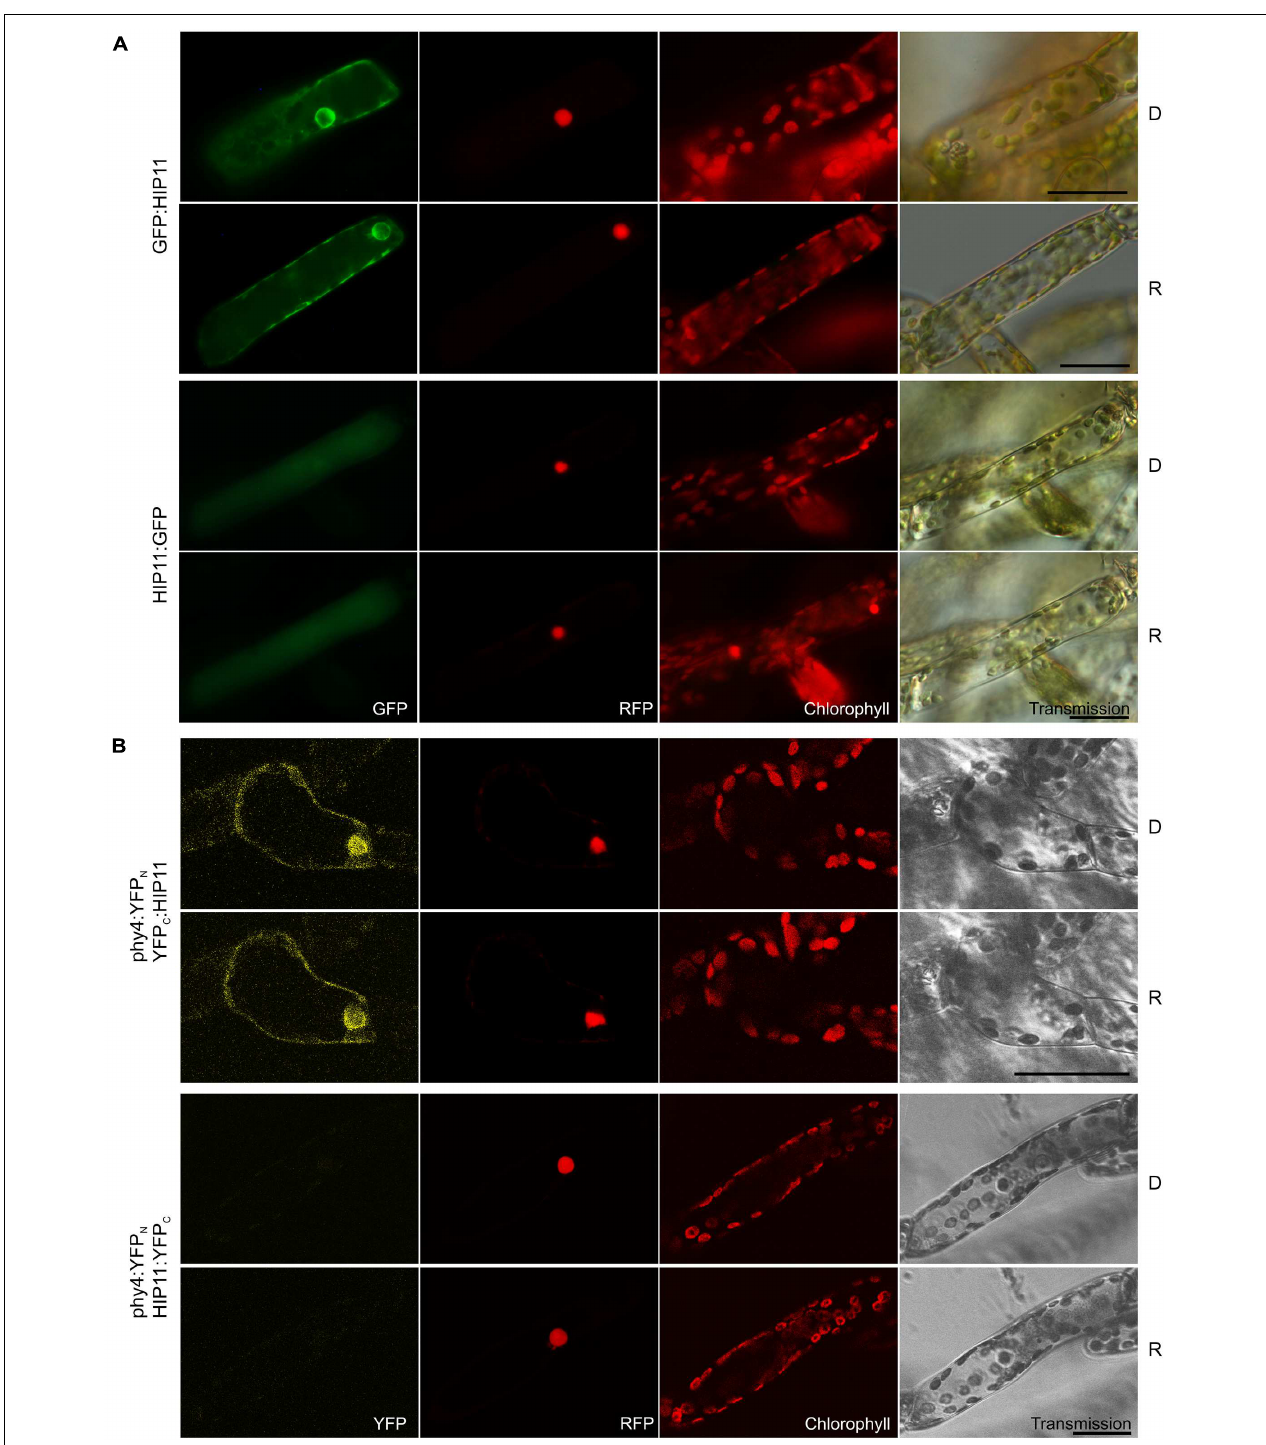
FIGURE 9 | HIP11 (Pp3c20_16210V1.1) intracellular localization (A) and split-YFP-studies of HIP11–phy4 interaction (B) each without (D) and with R pre-treatment (R) using fluorescence- and confocal microscopy, respectively. Overall figure structure is analogous to Figure 1 . (A) GFP:HIP11 (rows 1 and 2) and HIP11:GFP (rows 3 and 4) showed cytoplasmic and perinuclear or cytoplasmic localization, respectively (column 1, GFP). In a subset of cells cytoplasmic and nuclear localization could be observed in both cases (not shown). (B) Corresponding to the Y2H interaction behavior, split-YFP configurations in combination